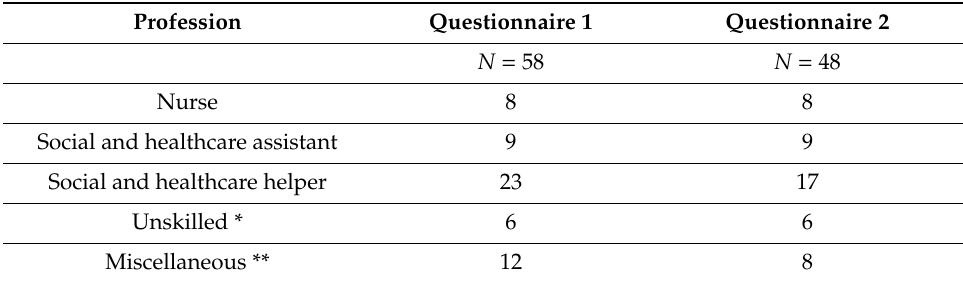
Table 2. Overview of the distribution of professions answering the questionnaire before and after the workshop.